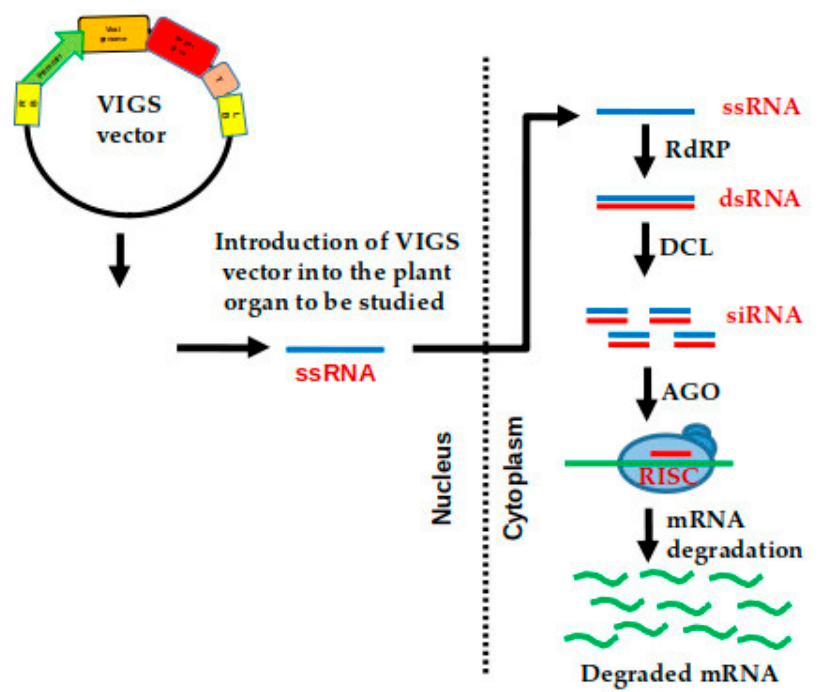
Figure 3. Represents the virus-induced gene silencing (VIGS) mechanism in tomato. This technique allows transient expression of the target gene introduced through viral vectors into the plant. Once the vector is released in the plant, the single-stranded RNA (ssRNA) is converted to double-stranded RNA (dsRNA), which is further cleaved by dicer-like (DCL) enzymes and loaded to protein Argonaute (AGO) to generate short interfering RNAs (siRNA). The siRNA enters the RNA-induced silencing complex (RISC) to initiate the degradation of targeted mRNA, thereby silencing the gene function. RNA dependent RNA polymerase (RdRP). VIGS vector contains: Left Border (LB) and Right Border (RB) highlighted in yellow; Promoter in green; Viral genome in orange; Target gene in red; Terminator (T).